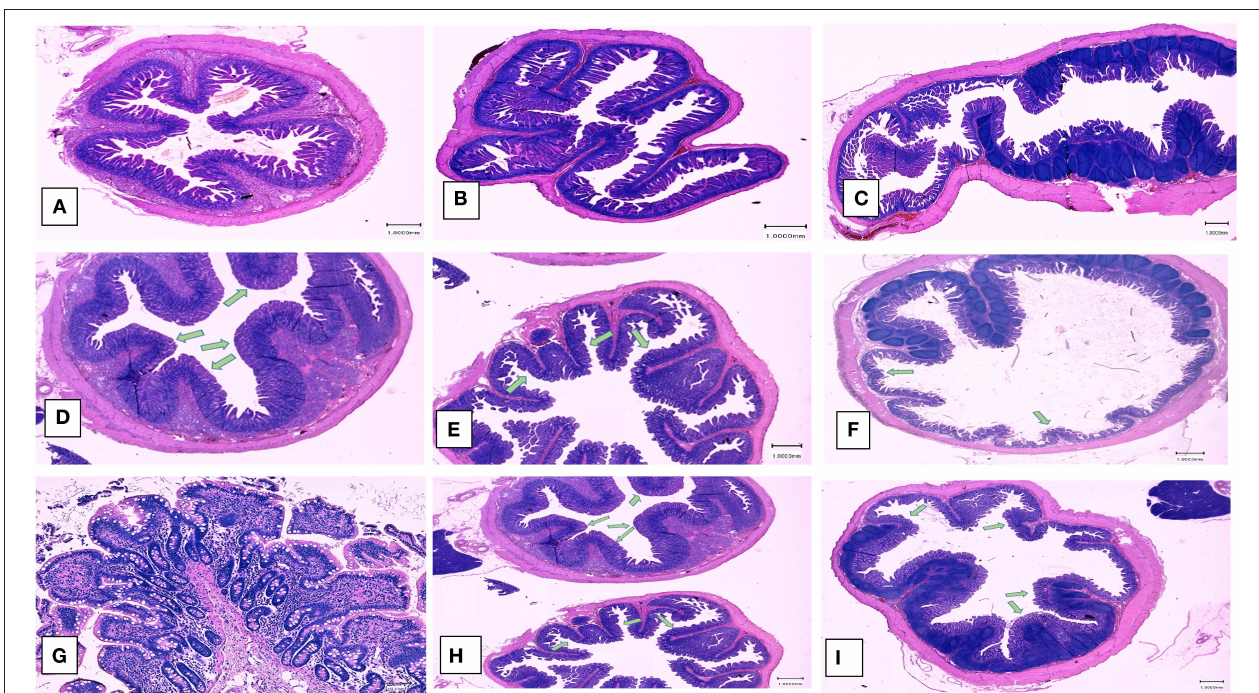
FIGURE 5 | Post-challenge histopathology of small intestines. Left panel (A,D,G) Hematoxylin and eosin stained sections showing representative microscopic lesions (10X magnification). (A–C) Healthy pigs. (A) Duodenum, (B) Jejunum, (C) Ileum, (D–G) Unvaccinated, PEDV challenged pigs, (D) Duodenum, (E) Jejunum, (F) Ileum, (G) Ileum (100x). (H,I) Pigs vaccinated with the irradiated vaccine and challenged (D) Duodenum and Jejunum (F) Ileum. Green arrows indicate areas of villus atrophy and crypt hyperplasia.